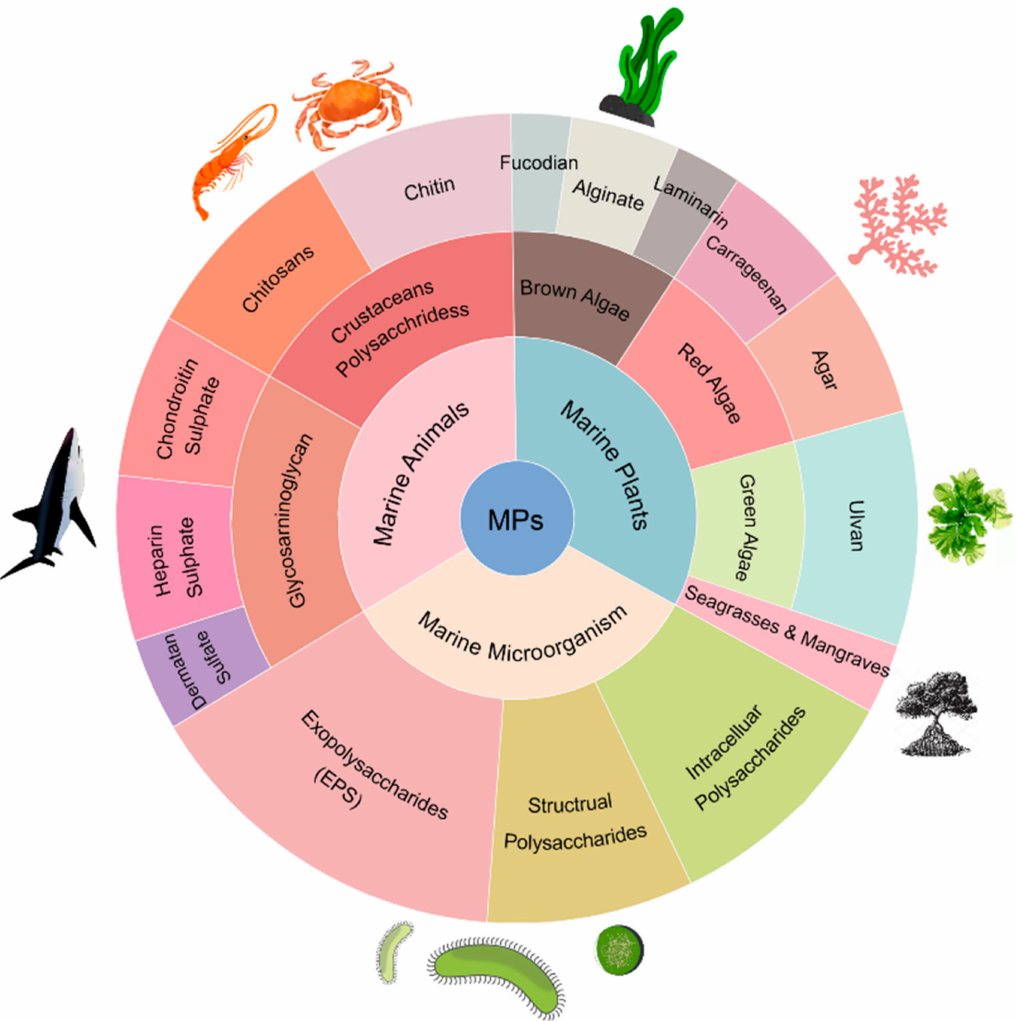
Figure 3. Classification of marine